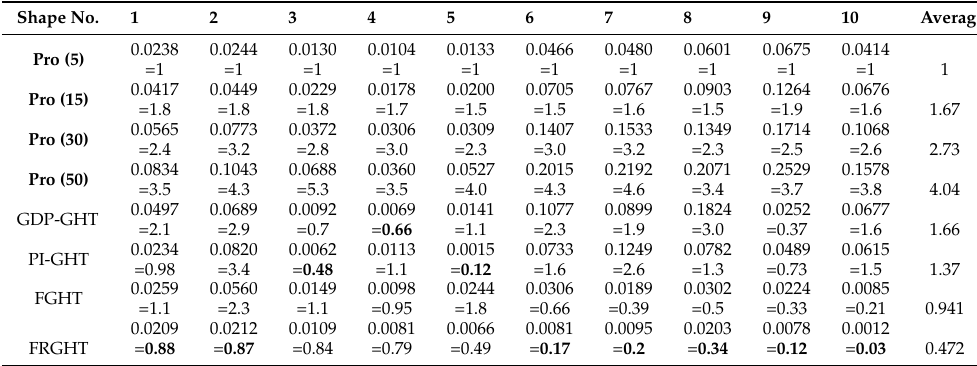
Table 1. Runtime efficiency for all shapes in the dataset for different algorithms in seconds. Shape